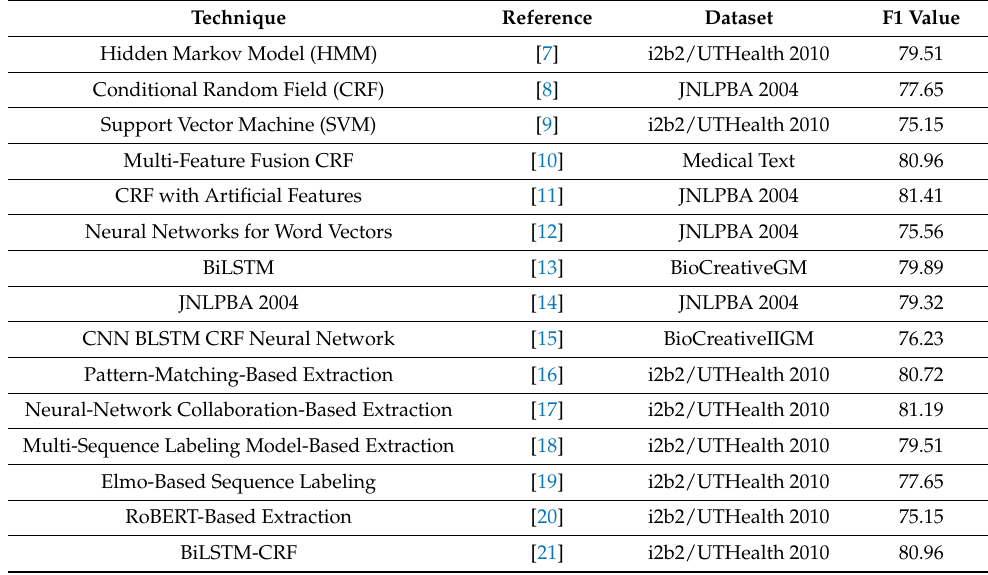
Table 1. A Comprehensive Comparison of Medical Information Extraction